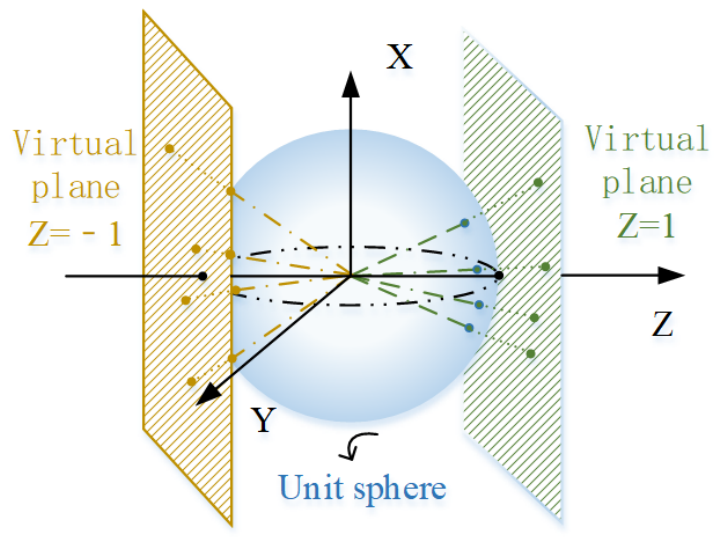
Figure 2. Virtual camera coordinate system.